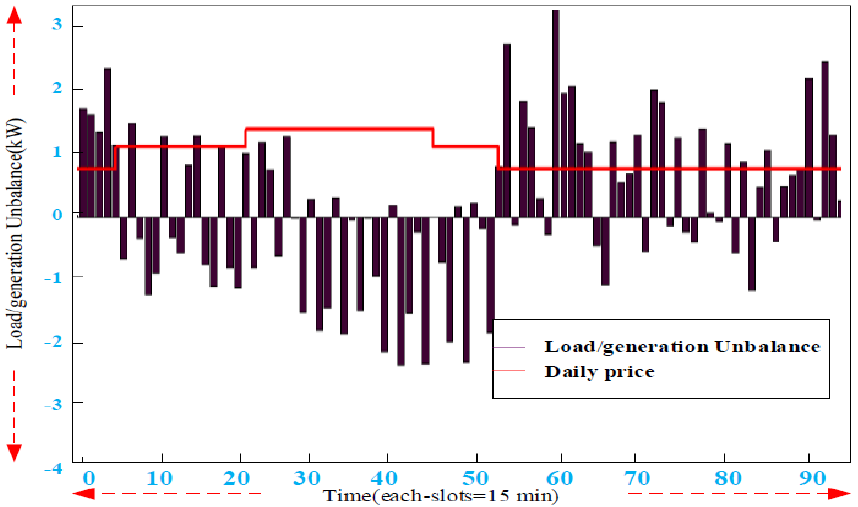
Figure 19. Difference between power generation and consumption in HAEMS in a 24 h day.